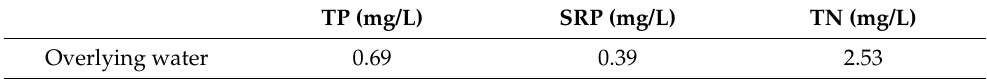
Table 2. Raw Nitrogen and Phosphorus Content of the Overlying Water